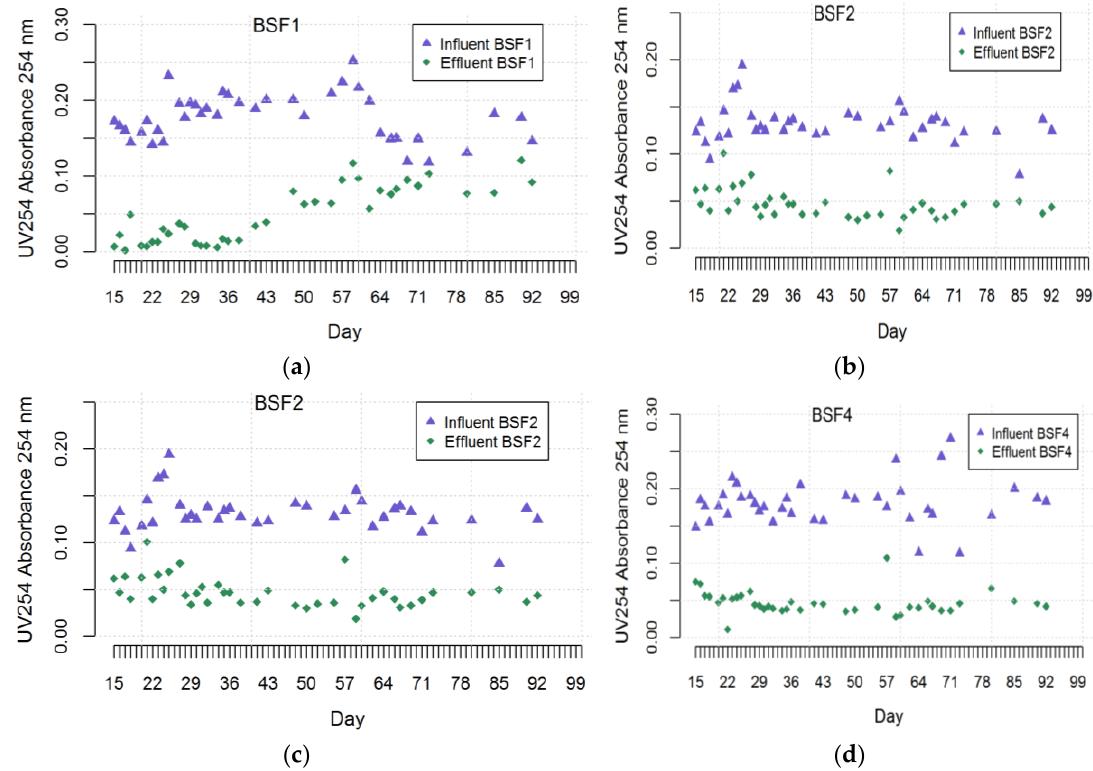
Figure 6. Influent vs. effluent absorbance at 254 nm over the course of the experiment: ( a ) BSF1, ( b ) BSF2, ( c ) BSF3 and ( d ) BSF4.